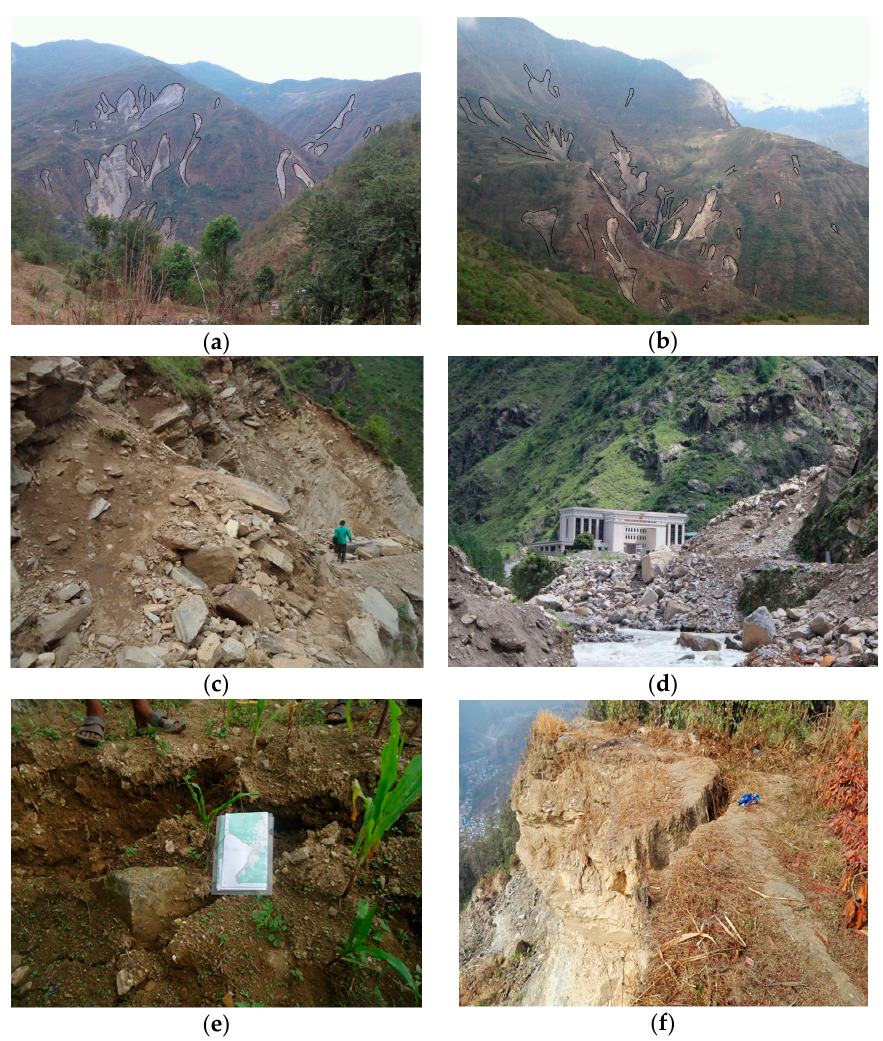
Figure 3. Co-seismic landslides observed during field survey: ( a , b ) landslides initiated on steep slopes; ( c ) rock topple; ( d ) rockslide partially damming the Bhote Koshi at Rasuwagadhi; ( e ) observed cracking; ( f ) hanging block. Table 1. Data type, source and scale.